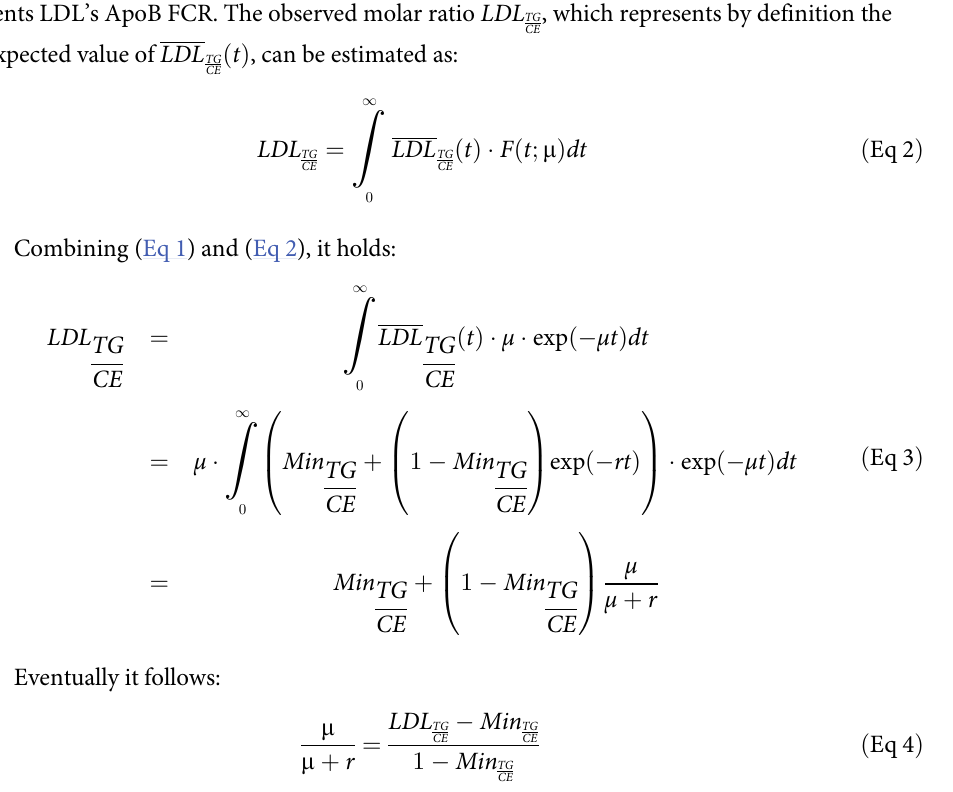
� � , which is the mean CE